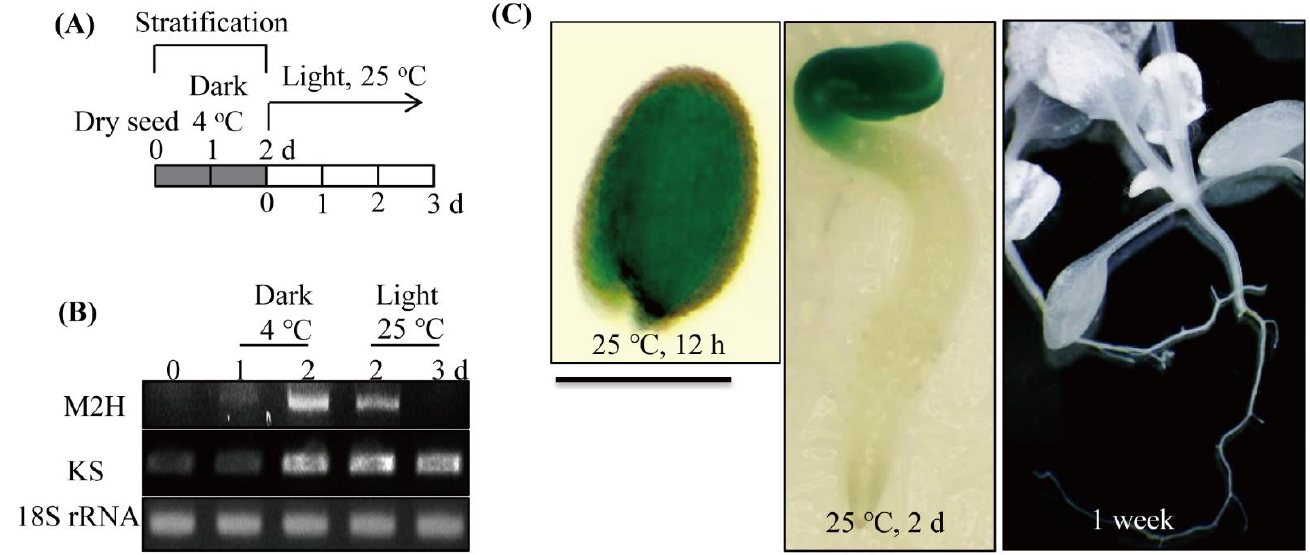
Figure 3. Melatonin 2-hydroxylase ( M2H ) expression in non-dormant Arabidopsis thaliana WT seeds during stratification and germination. ( A ) Schematic diagram of stratification and germination procedures. ( B ) RT-PCR analysis results for M2H and KS in WT seeds. ( C ) In situ β -glucuronidase (GUS) expression patterns at various stages of germination and in 1-week-old seedlings. WT seeds were imbibed at 4 °C in the dark for 2 days, and then transferred into light conditions at 25 °C. The pGWB533-M2H promoter:GUS transgenic line was used for GUS staining. The seed coat was removed for photograph after GUS staining on the embryo at 12 h under light incubation. Bar = 0.3 mm. GenBank accession numbers were as follows: M2H , melatonin 2-hydroxylase (At3g60290); KS , ent-kaurene synthase (AT1g79460); 18s rRNA (AT1g80340).